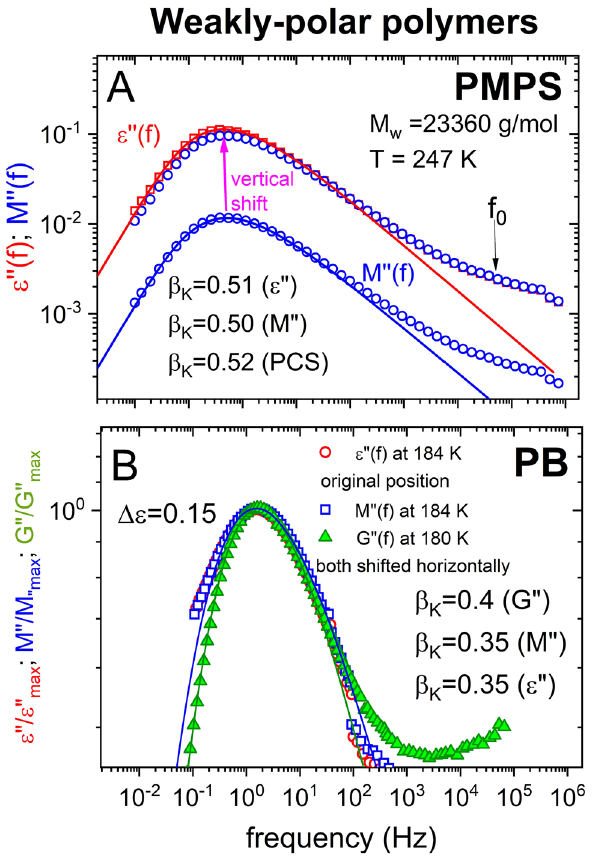
Figure 8. ( A ) Shows the ε ″ ( f ) and M ″ ( f ) data of the polymer PMPS at 247 K, and the vertically shifted M ″ ( f ). The K-exponents are β DS K = 0.51, β M K = 0.50, and β PCS K = 0.52 for the α-relaxation in ε ″ ( f ), M ″ ( f ), and PCS respectively. The arrow indicates the dielectric primitive relaxation frequency f 0 ≈ f JG calculated by Eq. (2) with β DS K = 0.51. ( B ) Shows the normalized ε ″ ( f ), M ″ ( f ), and G ″ ( f ) data of the polymer polybutadiene at 184 K and 180 K, and the Kohlrausch fits with β DS K = 0.35, β M K = 0.35, and β G K = with values decreasing with falling temperature in the range 0.53–0.62. There is good agreement between β DS K = 0.55 and β PCS K = 0.53 at temperatures near T g = 263 K, and this result provides strong support of the prediction. Polyphenyl ether (PPE). The value Δε = 1.45 of PPE is nearly the same as BMPC. The frequency dispersions of the α-loss peaks in ε ″ ( f ), M ″ ( f ), and G ″ ( f ) are compared in Fig. 7C. From the Kohlrausch fits, the values of the exponents β DS K , β M K , and β G K are 0.62, 0.56, and 0.58 respectively. Thus the α-relaxations in M ″ ( f ), and G ″ ( f ) have effectively the same frequency dispersion, and it is slightly narrower in ε ″ ( f ). The situation is similar to BMPC. Tetramethyltetraphenyltrisiloxane (DC704). The value Δε = 0.2 of DC704 is an order of magnitude smaller than BMPC and PPE, and should be a better candidate to test the expected behavior. The frequency dispersions of the α-loss peaks in ε ″ ( f ), M ″ ( f ), and G ″ ( f ) from Ref. 57 are compared in Fig. 7D. The frequency dispersions of ε ″ ( f ) and M ″ ( f ) are identical, and the exponents β DS K and β M K are equal to 0.57. The equality is testament to the predic- tion of no change in the frequency dispersion in going from ε ″ ( f ) to M ″ ( f ) when the JG β-relaxation is far away from the α-relaxation. Moreover, the frequency dispersion in G ″ ( f ) is only slightly broader with the exponent β G β DS β M K = 0.53, a bit lower than 0.57 of K and K . By the way, the α-loss peak in χ ″ ( f ) from PCS measurements on DC704 has the same frequency dispersion as in ε ″ ( f ) and G ″ ( f ) 58 . Thus we have overwhelming evidence from DC704 to validate the predicted difference in the behavior of non-polar glass-formers than polar glass-formers when probed by methods different from dielectric susceptibility. Perhydrosqualene (squalane). Squalane has the smallest Δε among the examples given. The value is 0.009 according to Richert et al. 59 and 0.015 from Jakobsen et al. 48 . The frequency dispersions of the α-loss peaks in ε ″ ( f ) and G ″ ( f ) from Ref. 48 are compared in Fig. 7E together with M ″ ( f ) we calculated from ε *( f ). On first look, it seems the α-loss peaks in ε ″ ( f ), M ″ ( f ), and G ″ ( f ) are all the same. Indeed the frequency dispersions of ε ″ ( f ) and M ″ ( f ) are identical, and the exponents β DS K and β M K are equal to 0.52. The one in G ″ ( f ) is almost the same with β G K = 0.50. Like DC704 and polybutadiene, the data of squalene fully verify the prediction that the frequency